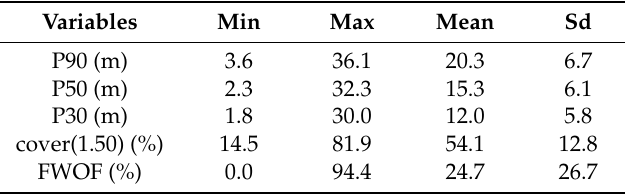
Table 3. Summary of lidar-derived metrics for